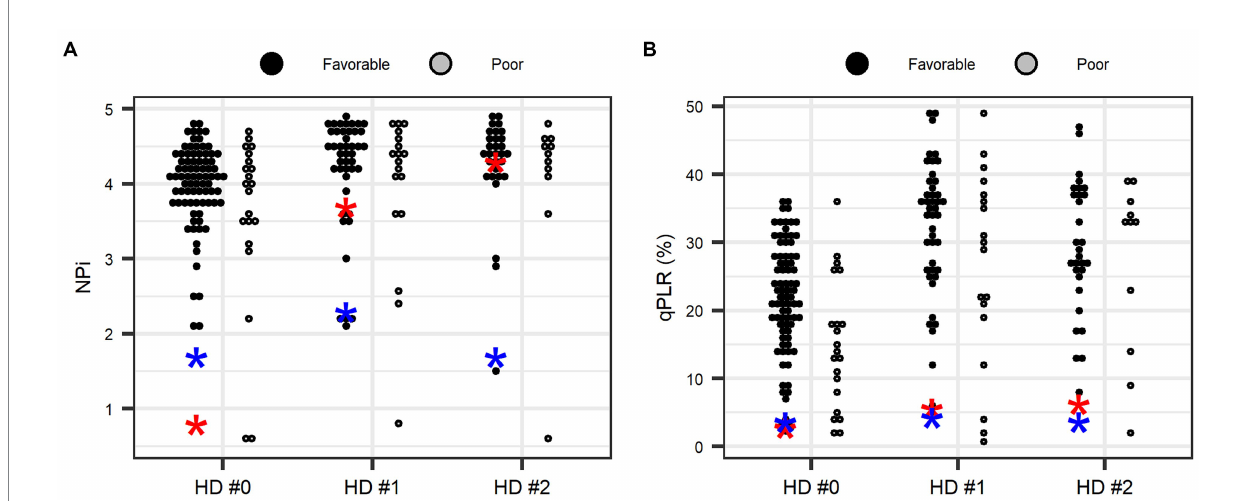
FIGURE 2 Distributions of neurological pupil index (A) and quantitative pupillary light reflex (B) during the first 3 days after carbon monoxide poisoning according to 1-month patient outcomes. NPi, neurological pupil index; qPLR, quantitative pupillary light reflex. *Blue and red colors indicate two patients with non-reactivity in standard PLR. Values represent the lowest value in each